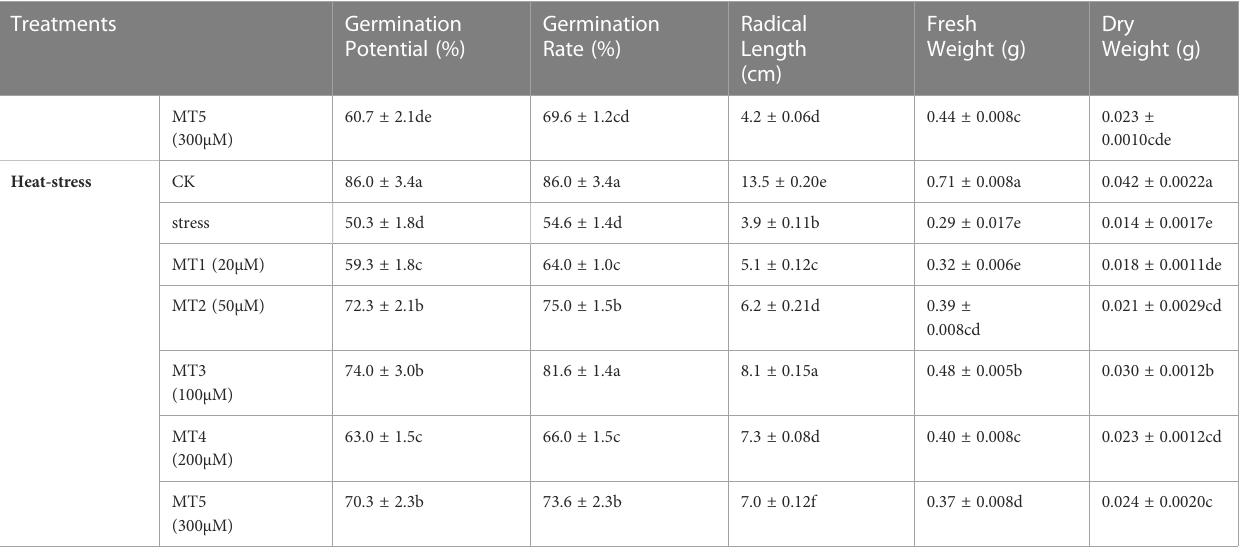
Values are the means ± SD (n=3). Different letters show a statistical signi fi cance level at p<0.05 . Here, μM is indicating (μmole L -1